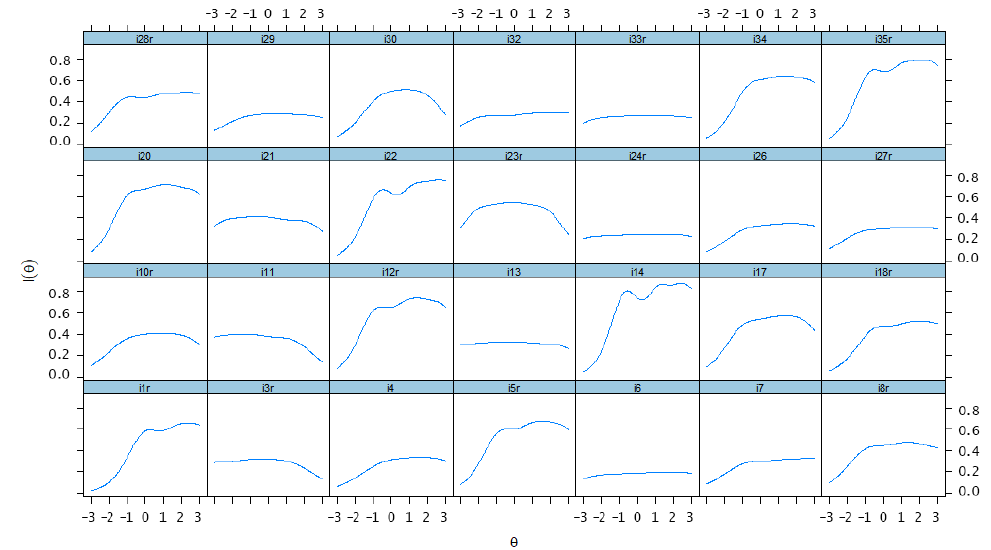
Figure 1. Item information of D28-C (the final Chinese version of D scale). r means that the corre- sponding item is negatively keyed.